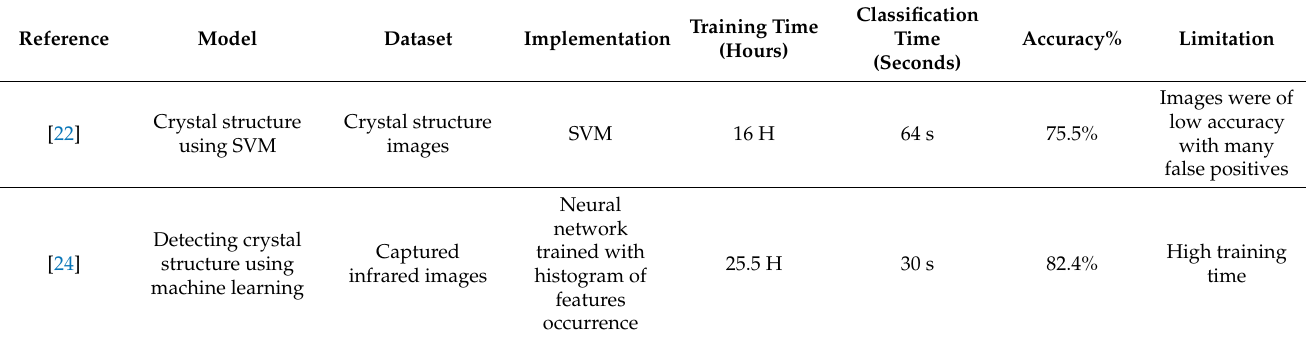
Table 1. Summary of different machine learning and deep learning models to detect the crystal structures in different